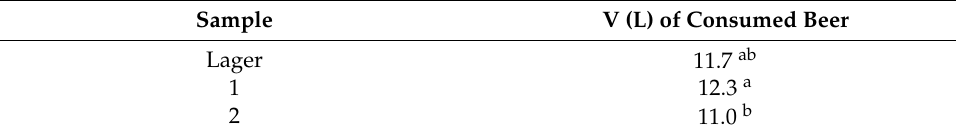
Table 5. Drinkability test